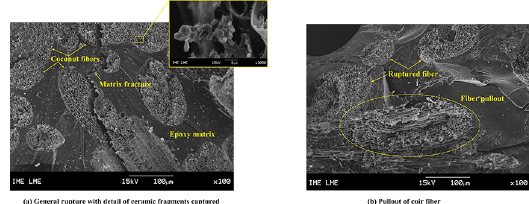
Figure 7. SEM fracture of a MAS with second layer of 30 vol% coir mantles-reinforced epoxy composite: (a) general rupture with detail of ceramic fragments captured and (b) pullout of coir